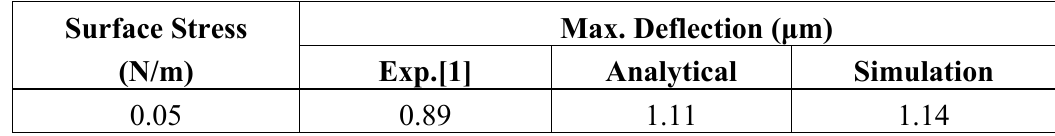
Table 1. Verification results comparing the experimental, analytical and simulation